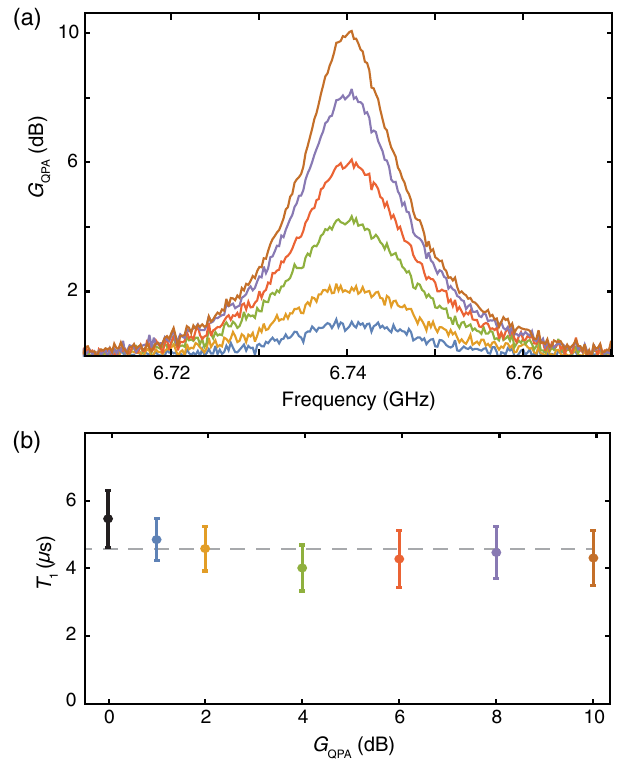
FIG. 7. (a) Gain profiles of the QPA for varying amounts of on- chip gain G as measured with a vector network analyzer. QPA (b) Qubit T 1 measured at several values of G corresponding to QPA the color-coded gain profiles in (a). Measurements are repeated for approximately 12 hr, during which time the order in which the gain settings are cycled through is repeatedly randomized. Error bars indicate the standard deviations of all results at each G QPA